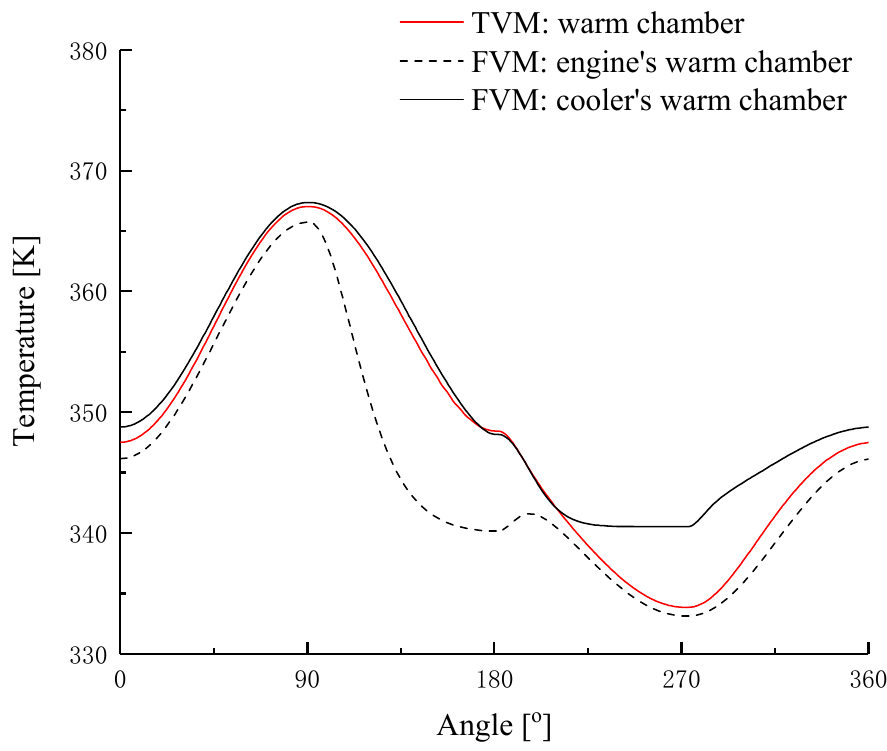
Figure 9. Variations of warm chamber’s temperature in TCVM and